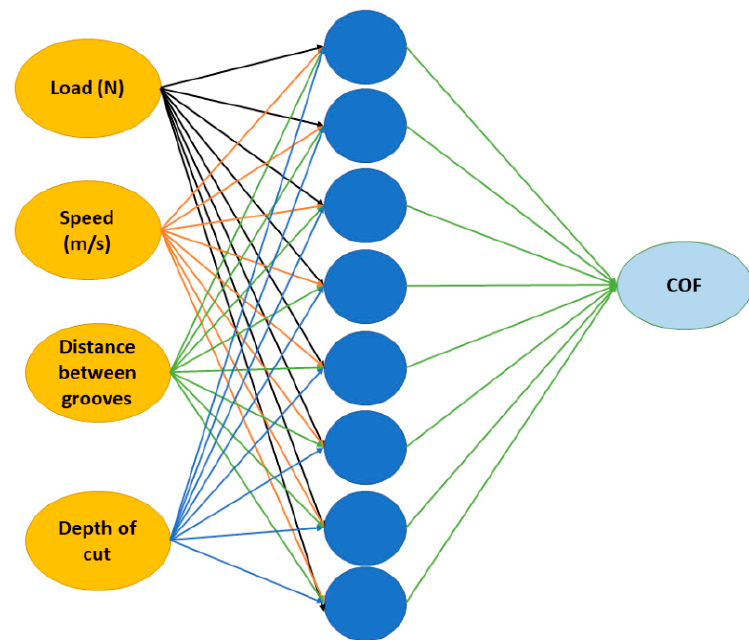
Figure 5. Typical 8-node ANN model used in this